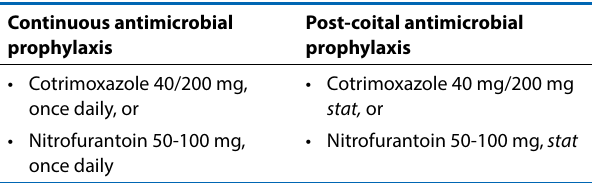
Table IV: Options for continuous and post-coital antimicrobial prophylaxis for women with recurrent urinary tract infections 12 Continuous antimicrobial